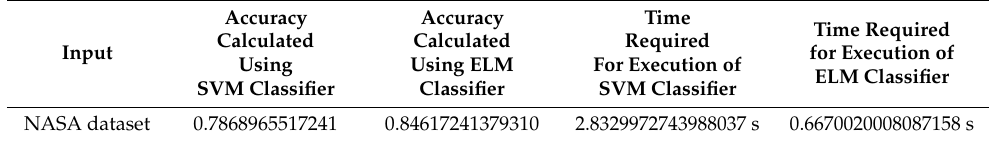
Table 1. Accuracy and Time Calculation Table.